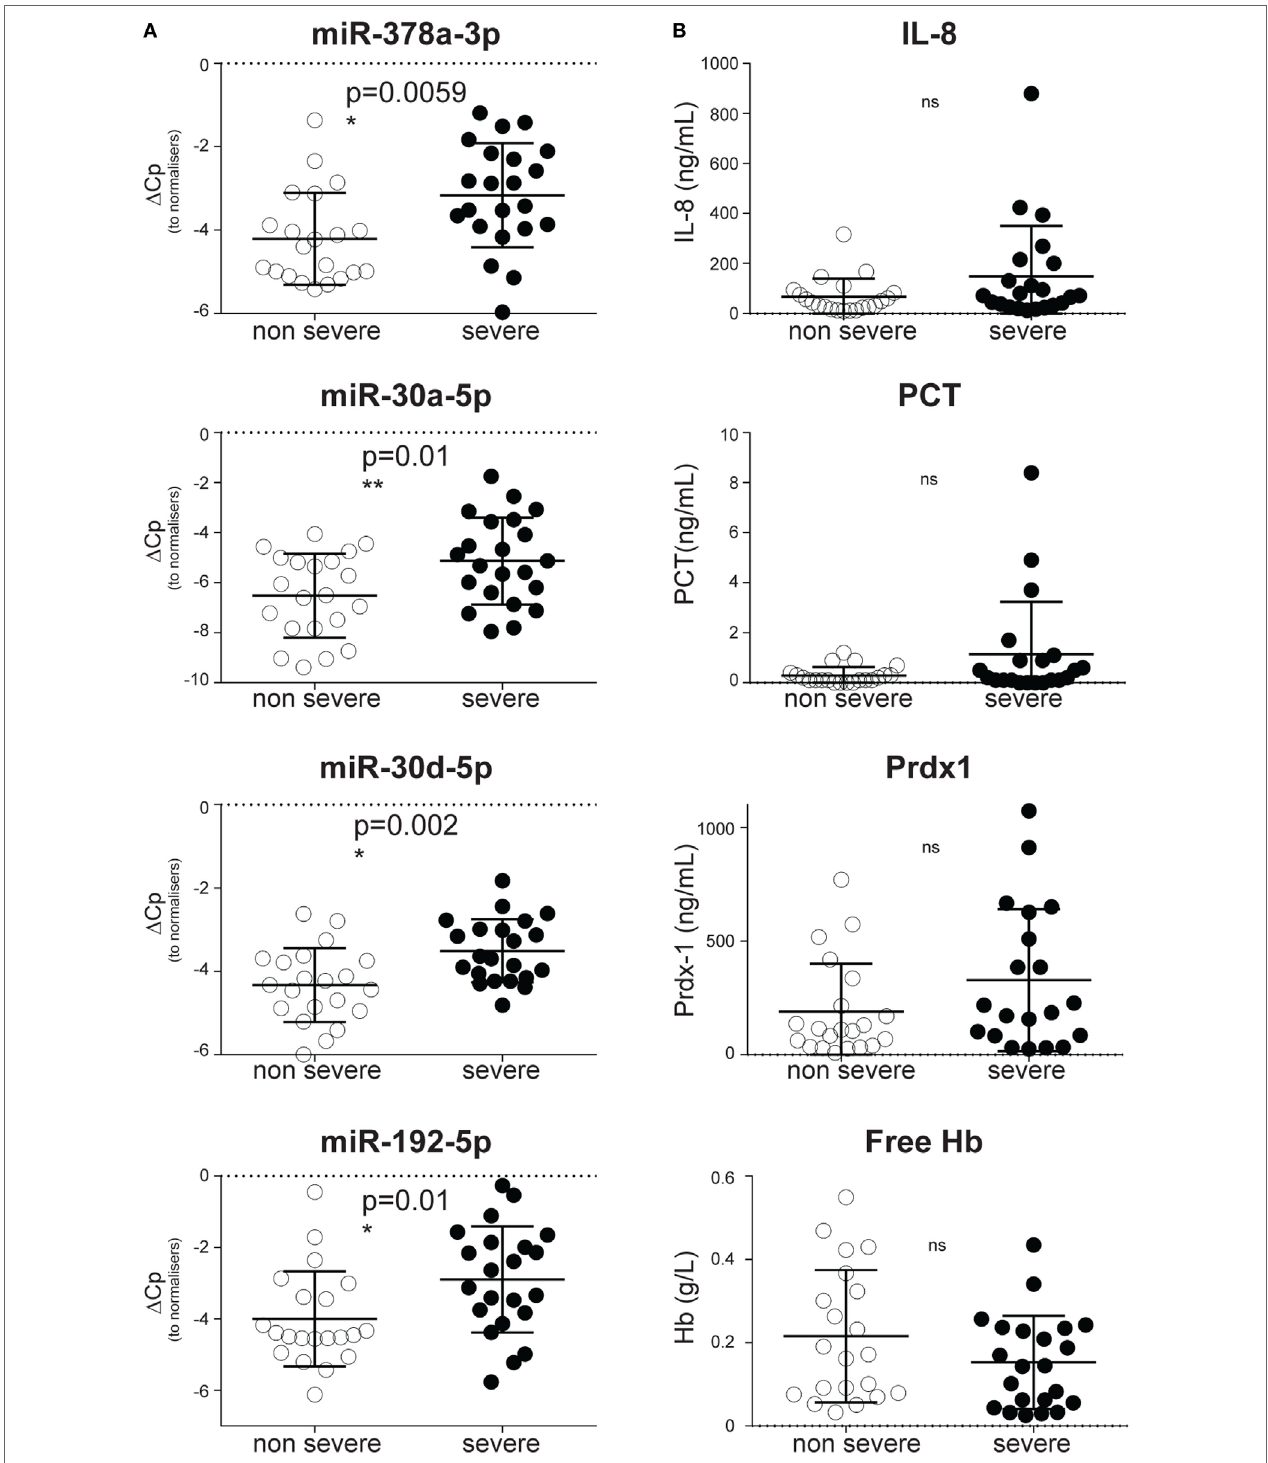
FigUre 3 | Circulating inflammatory-relevant microRNA biomarkers discriminate the severity of systemic inflammatory response syndrome (SIRS) better than inflammatory and stress mediators. In miRNA qPCR arrays, within each patient’s specimen, crossing point (Cp) of individual miRNAs were normalized as in Figure 1 and analyzed in patients with non-severe (open circles) and severe (filled circles) non-infective SIRS. Each symbol represents an individual patient. (a) Dot plots show delta Cp values for miR-378a-3p, miR-30a-5p, miR-30d-5p, and miR-192-5p in non-severe ( n = 21) and severe ( n = 22) non-infective SIRS patients, together with the level of significance. (B) Dot plots show concentration of IL-8, pro-calcitonin (PCT), peroxiredoxin-1 (Prdx-1) and free hemoglobin (Hb) in non-severe ( n = 21) and severe ( n = 22, apart from Prdx-1 in which n = 20) non-infectious SIRS patients, together with the level of significance.